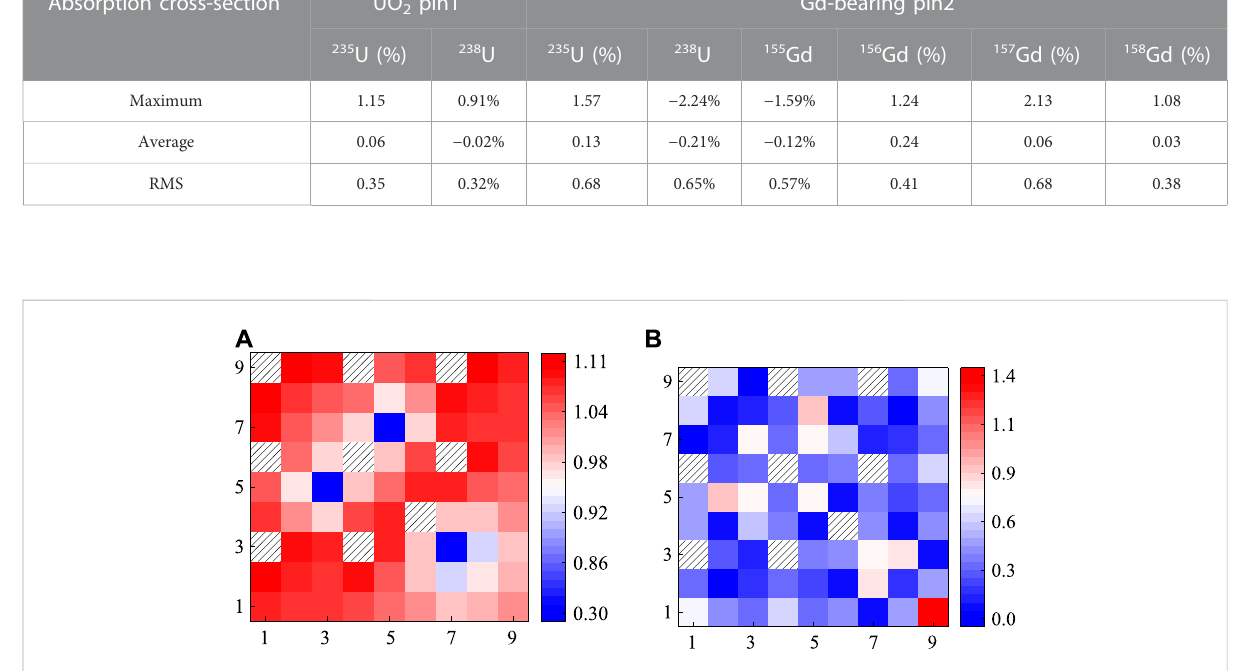
TABLE 10 Calculation results of the resonance cross-section of pins 1 and 2 of 4 × 4 lattice. Absorption cross-section UO 2 pin1 Gd-bearing pin2